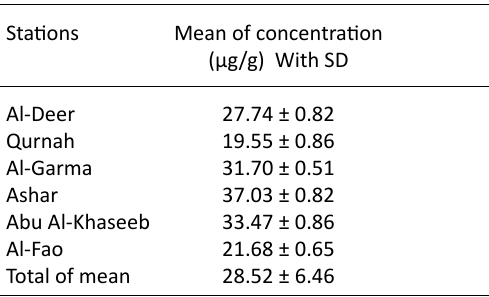
Table 2. The mean concentration of hydrocarbons with SD